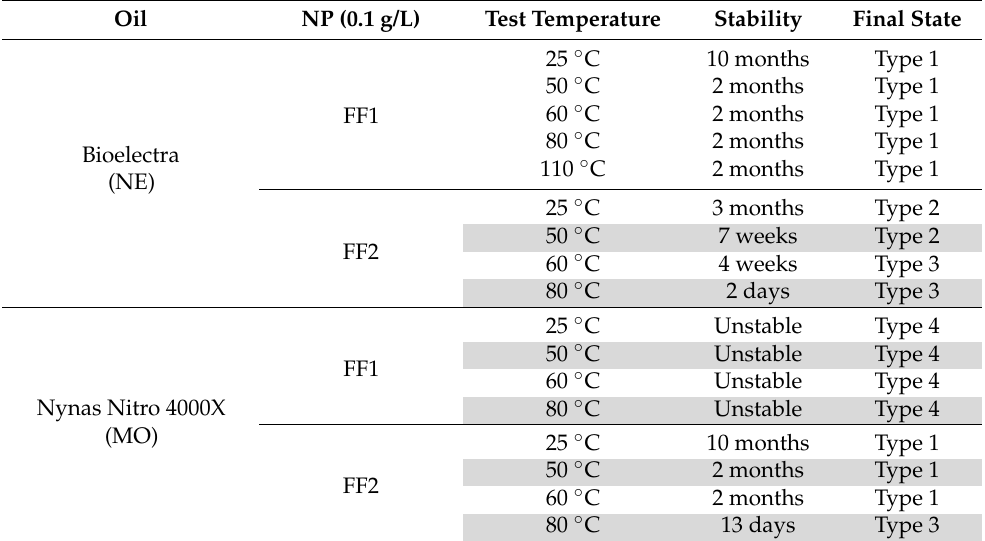
Table 3. Results of the stability tests according to the visual